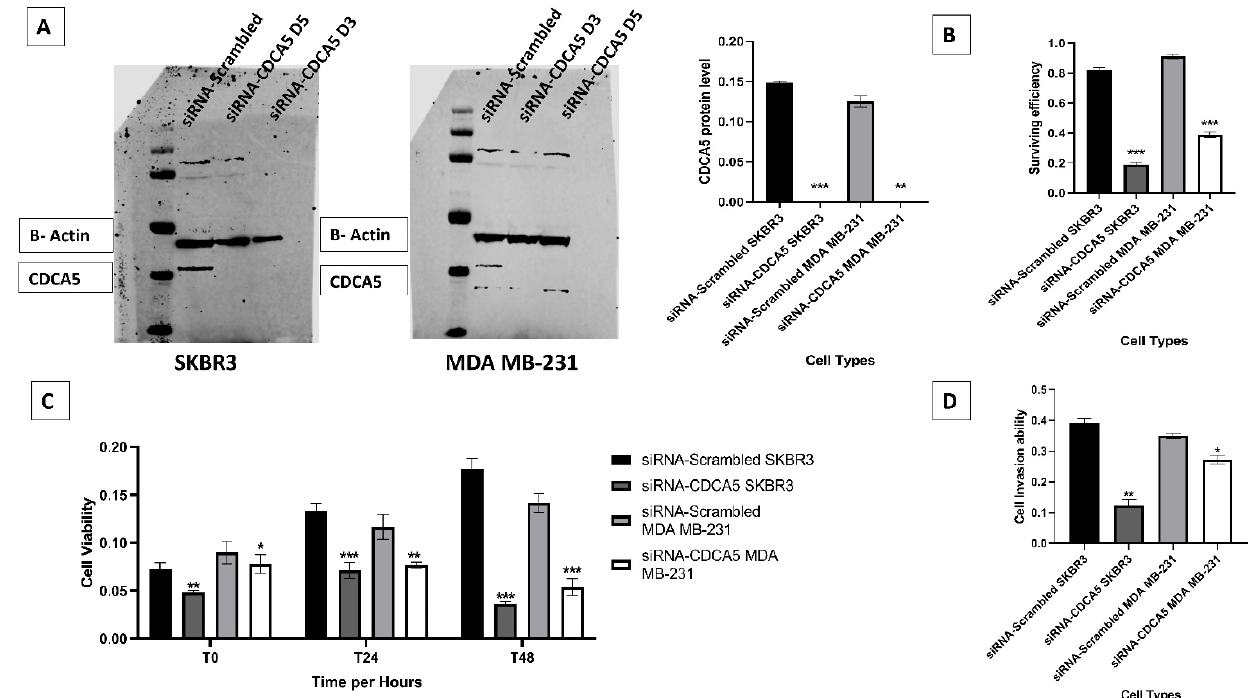
Figure 3. The protein expression of CDCA5 was evaluated in HER2-enriched (SKBR3) and TNBC (MDA MB-231) cell lines. ( A ) Western blot of CDCA5 levels in SKBR3 and MDA MB-231 BC cell lines transfected with CDCA5 siRNA and scrambled siRNA control. ( B ) Clonogenic survival assay for SKBR3, MDA MB-231 control and knockdown cells ( C ) Proliferation ability for SKBR3 and MDA MB-231 control and knockdown was evaluated using MTS assay. ( D ) Invasion assay quantification of SKBR3 & MDA MB-231 control and knockdown cells. p values are indicated as follows; ‘*’ p < 0.05, ‘**’ p < 0.01, ‘***’ p < 0.001. Error bar indicates standard error of the mean (SEM).